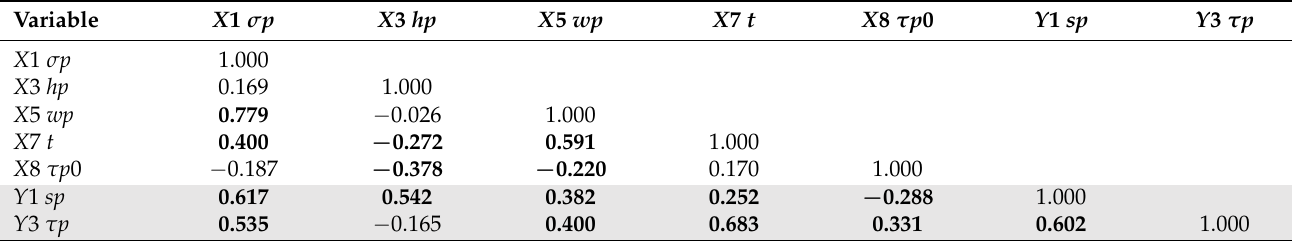
Table 3. Matrix of linear simple correlation coefficients r for peat.